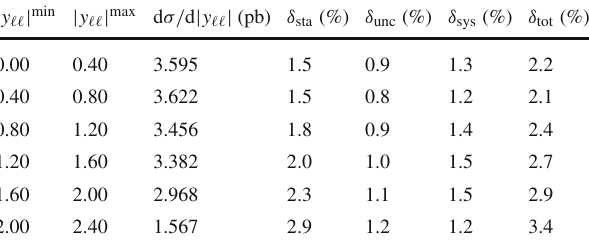
Table 24 Differential cross section for the Z /γ ∗ → e + e − process in the central region with 46 < m (cid:3)(cid:3) < 66 GeV, extrapolated to the common fiducial region. The relative statistical ( δ sta ), uncorrelated sys- tematic ( δ unc ), correlated systematic ( δ sys ), and total ( δ tot ) uncertainties are given in percent. The overall 1 . 8% luminosity uncertainty is not included